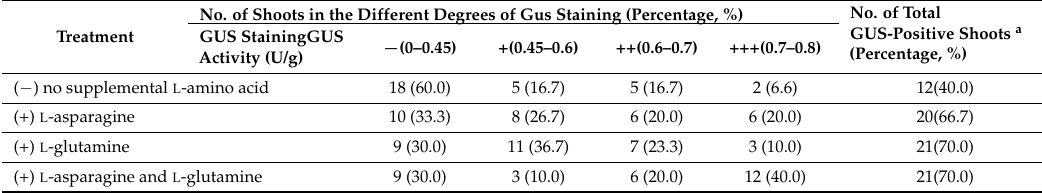
Table 2. Expression ofmultiple shoots as determined by GUS staining and GUS activity. Treatment